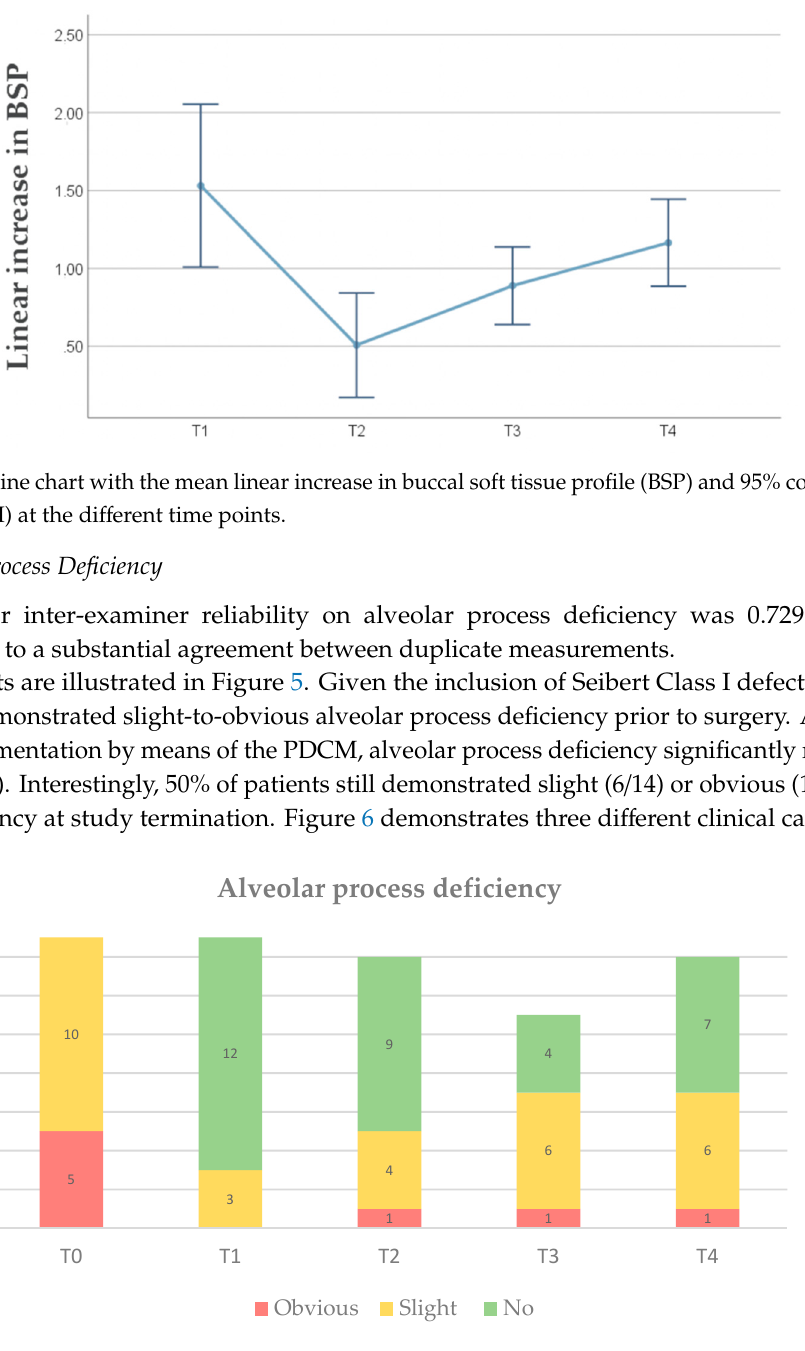
Figure 5. Bar chart on alveolar process deficiency at T0 (pre-op, n = 15), T1 (immediately post-op, n = 15), T2 (3 months, n = 14), T3 (1 year, n = 11) and T4 (3 years, n = 14).